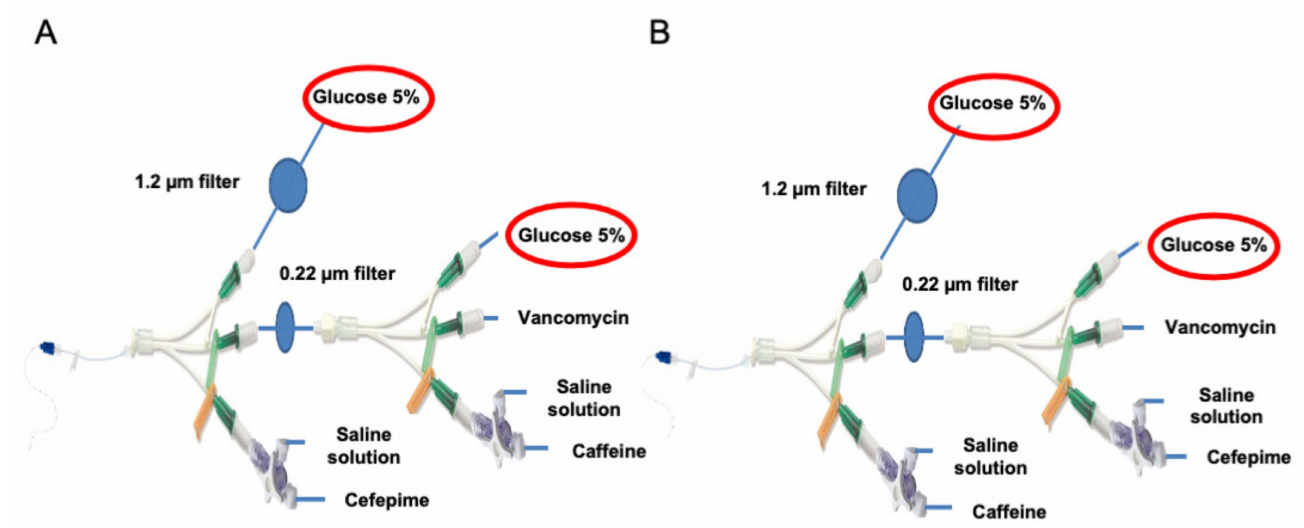
Figure 2. Replicated infusion line used in the laboratory. Modified CEF infusion line with replacement of binary parenteral nutrition infusion and lipid emulsion infusion by G5% infusion ( A ); Modified CAF infusion line with replacement of binary parenteral nutrition infusion and lipid emulsion infusion by G5% infusion ( B ).